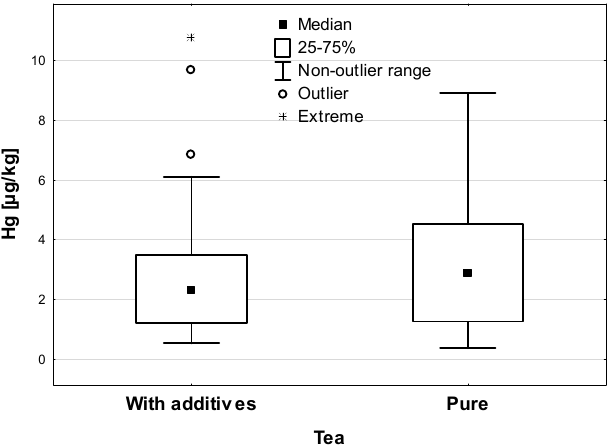
Figure 4. Hg concentration in pure and additives tea ( μ g/kg).